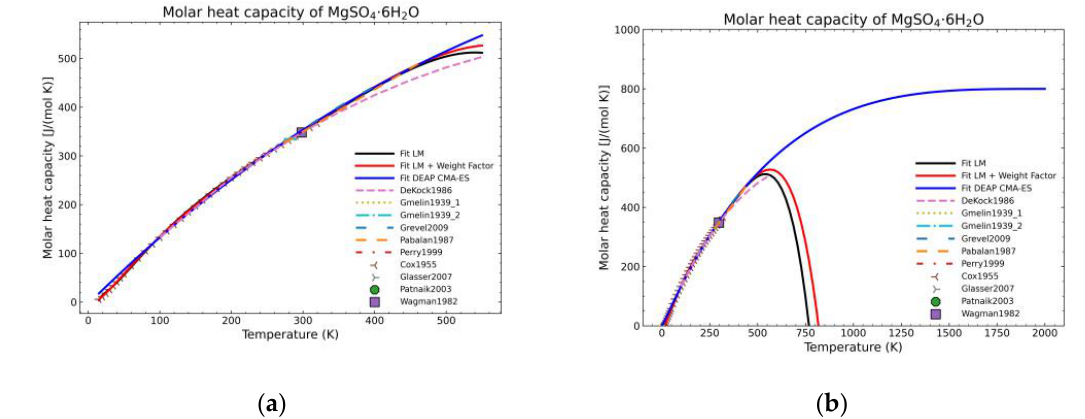
Figure 10. Comparison of the different fit results of MgSO 4 ·6H 2 O showing: ( a ) literature points area; ( b ) extended range until 2000 K.